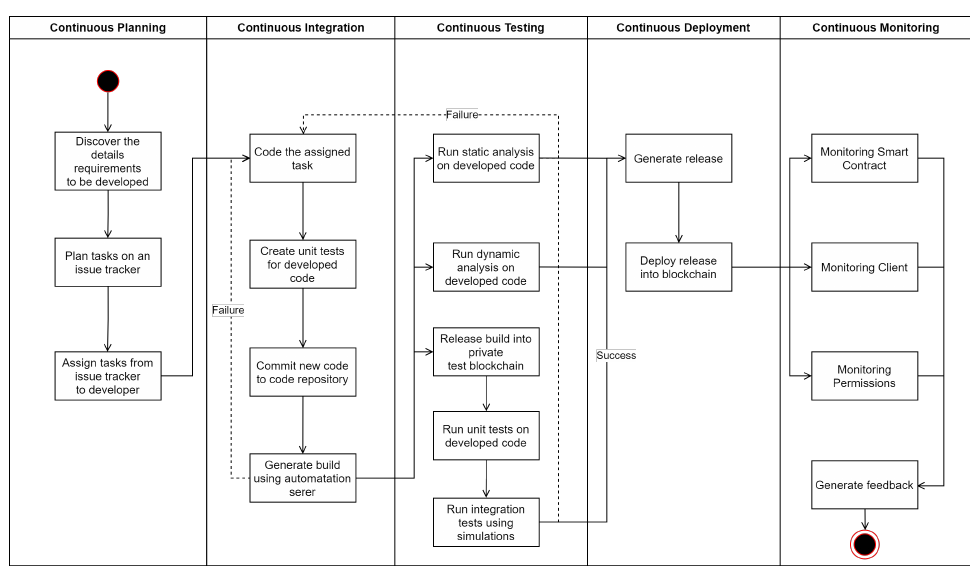
Figure 2. Framework